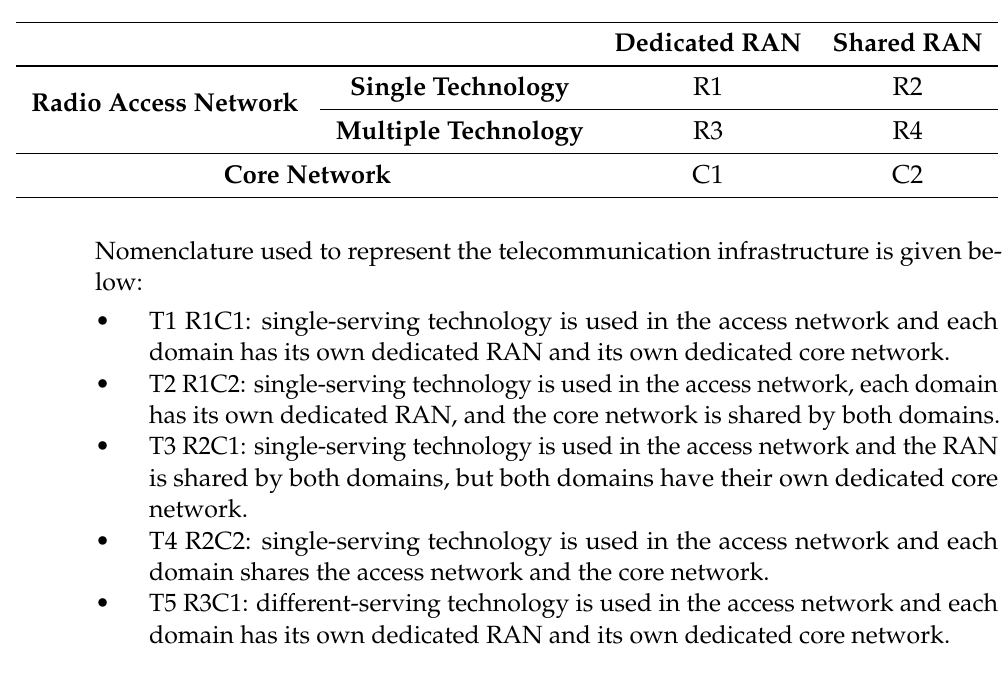
Table 1. Considered combination cases for radio access and core network